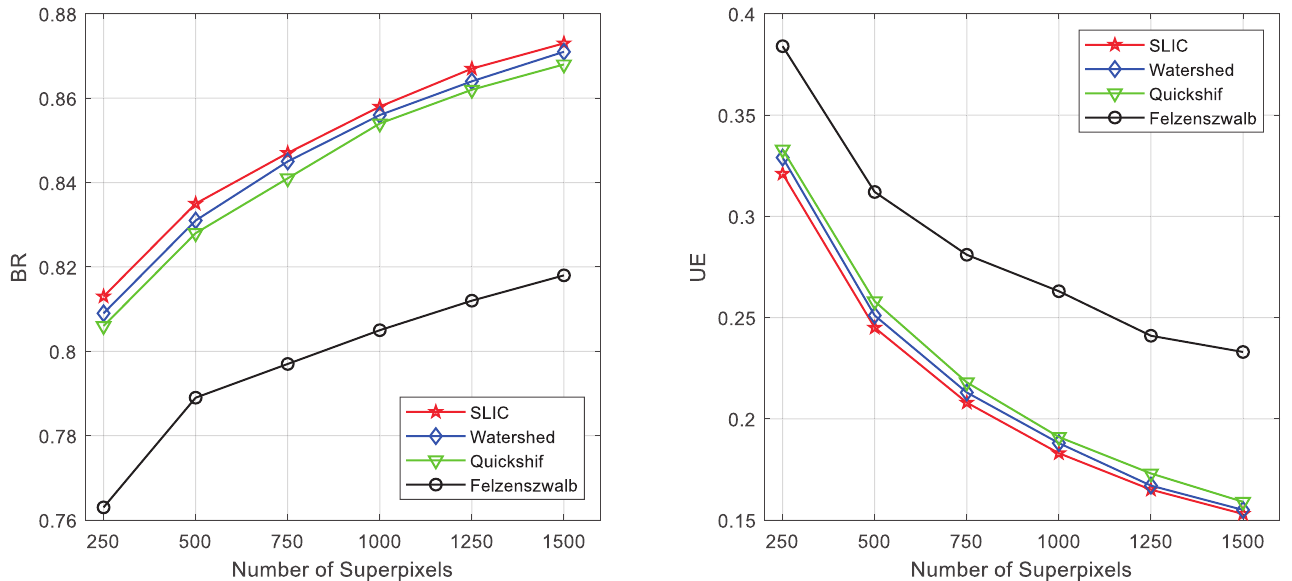
Figure 6. Comparison of superpixel segmentation algorithms